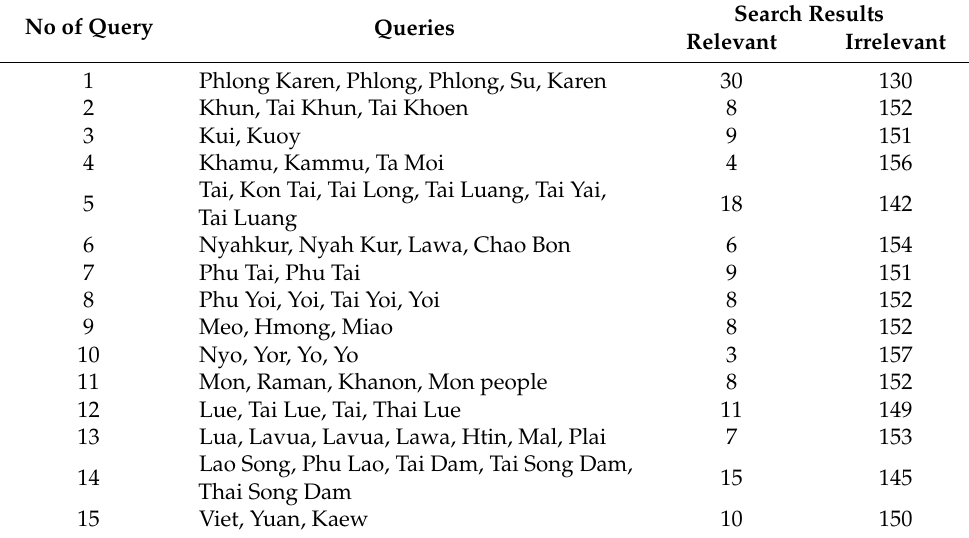
Table 2. Query selection and search results.